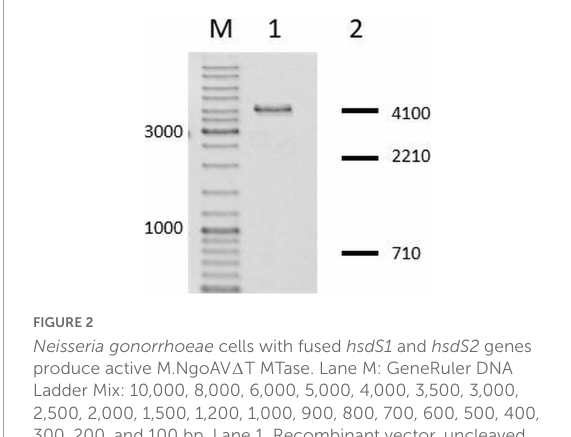
FIGURE2 Neisseria gonorrhoeae cells with fused hsdS1 and hsdS2 genes produce active M.NgoAV (cid:49) T MTase. Lane M: GeneRuler DNA Ladder Mix: 10,000, 8,000, 6,000, 5,000, 4,000, 3,500, 3,000, 2,500, 2,000, 1,500, 1,200, 1,000, 900, 800, 700, 600, 500, 400, 300, 200, and 100 bp. Lane 1. Recombinant vector, uncleaved by HincII, due to methylation of overlapping sites by